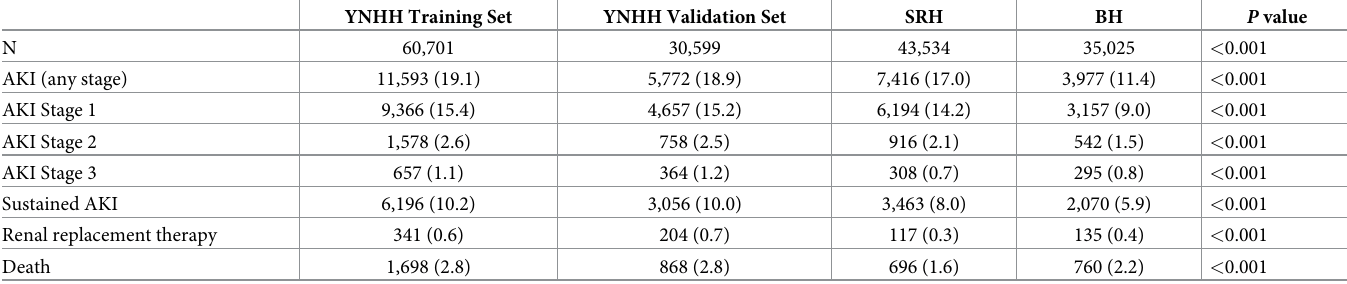
Table 2. Patient outcomes within training and testing cohort. Outcomes within the training and test cohort. Values are N (%). P values represent differences across the three test